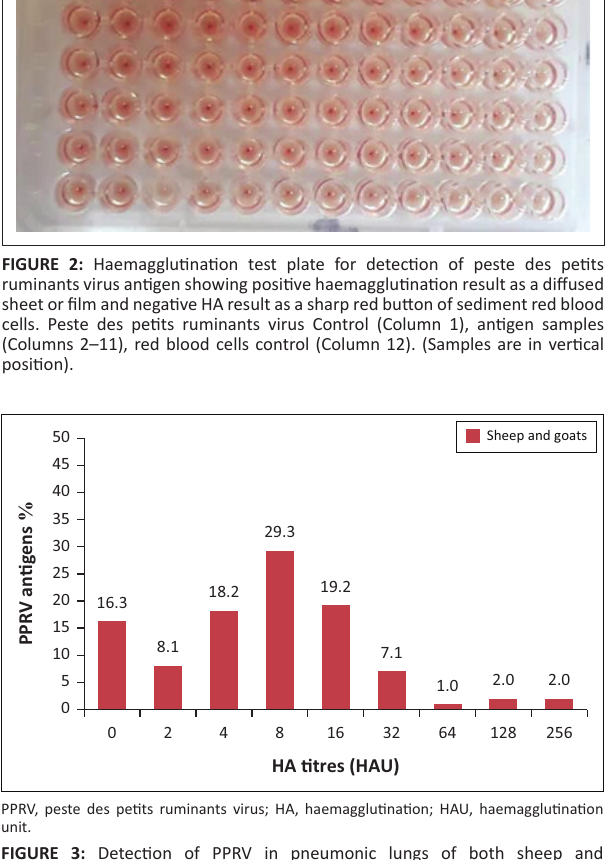
FIGURE 3: Detection of PPRV in pneumonic lungs of both sheep and goat collected from Al-Hasaheisa slaughterhouse, Sudan. Distribution of haemagglutination